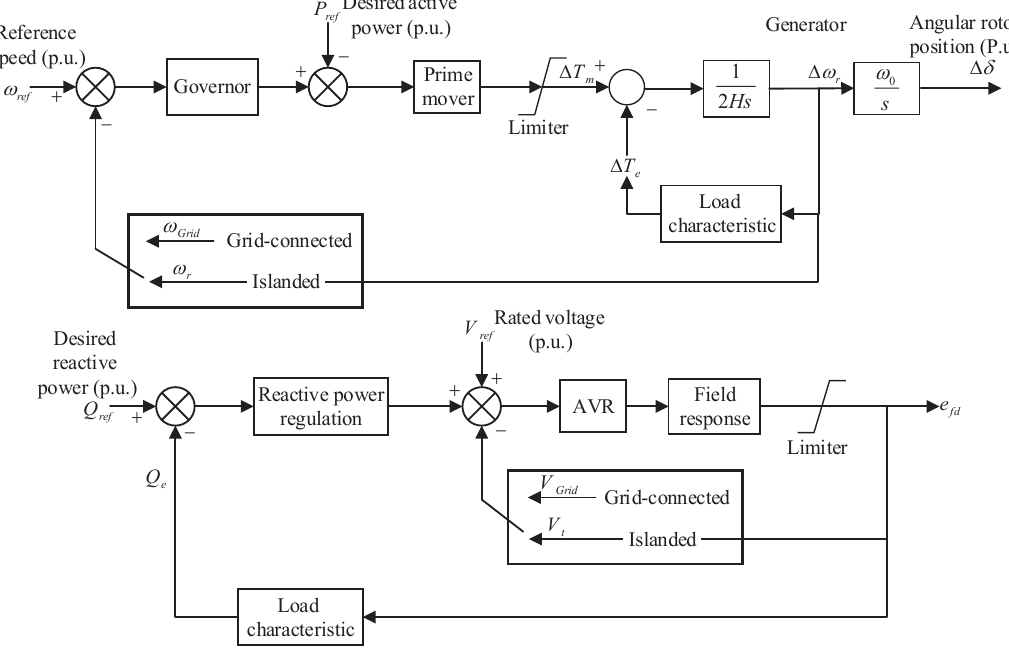
Figure 1. Control block diagram of active and reactive power control